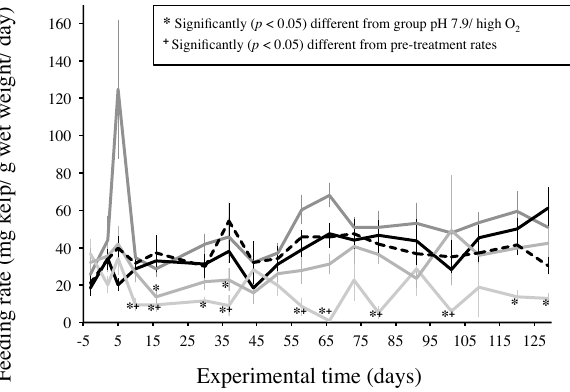
Figure 4. S. fragilis feeding rates before and during exposure to extreme (pH 6.6), high (pH 2 Fig. 4. S. fragilis feeding rates before and during exposure to ex- 7.2), moderate (pH 7.6) and control (pH 7.9) p CO 2 at in situ O 2 levels, and to control p CO 2 3 treme (pH 6.6), high (pH 7.2), moderate (pH 7.6) and control (pH (pH 7.9) at 100% air saturation. Feeding rates are shown as mean ± SEM. 4 7.9) p CO 2 at in situ O 2 levels, and to control p CO 2 (pH 7.9) at 100% air saturation. Feeding rates are shown as mean ± SEM.